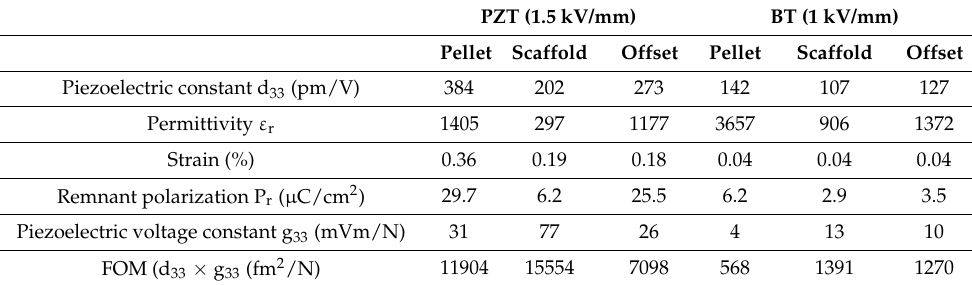
Figure 6. A comparison of piezoelectric properties ( a ) Polarization hysteresis and ( b ) strain hysteresis measured on a pressed sample and 3D printed scaffold structures for PZT; ( c ) polarization hysteresis and ( d ) strain hysteresis measured on a pressed sample and 3D printed scaffold structures for BT. Table 1. A comparison of electrical properties in pellet sample (pressed), 3D printed open (scaffold) and offset (offset) scaffold structure of PZT and